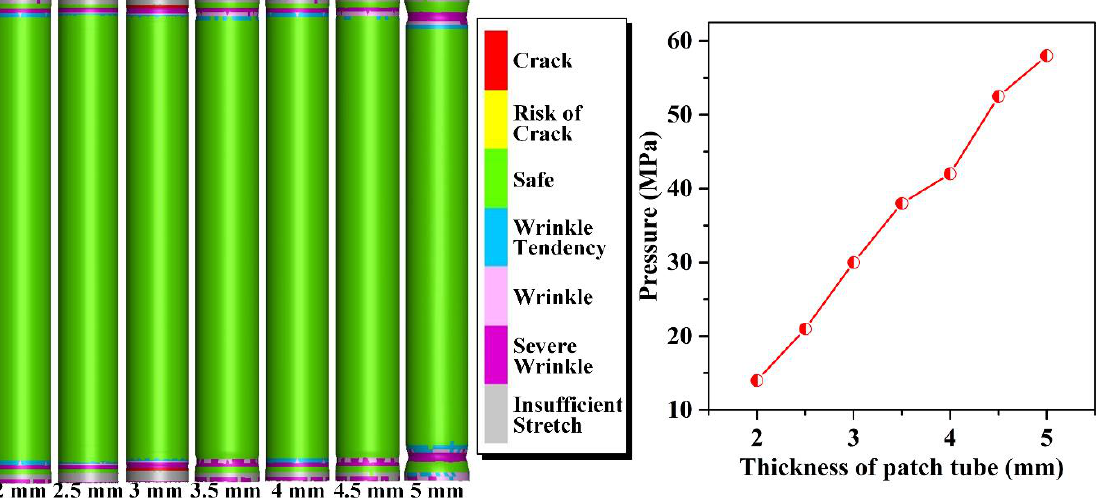
Figure 12. Influence of different thickness levels on forming